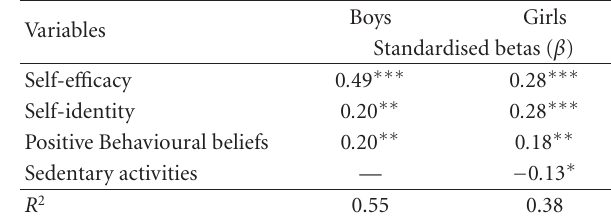
Table 2: Final models of the determinants of intention according to